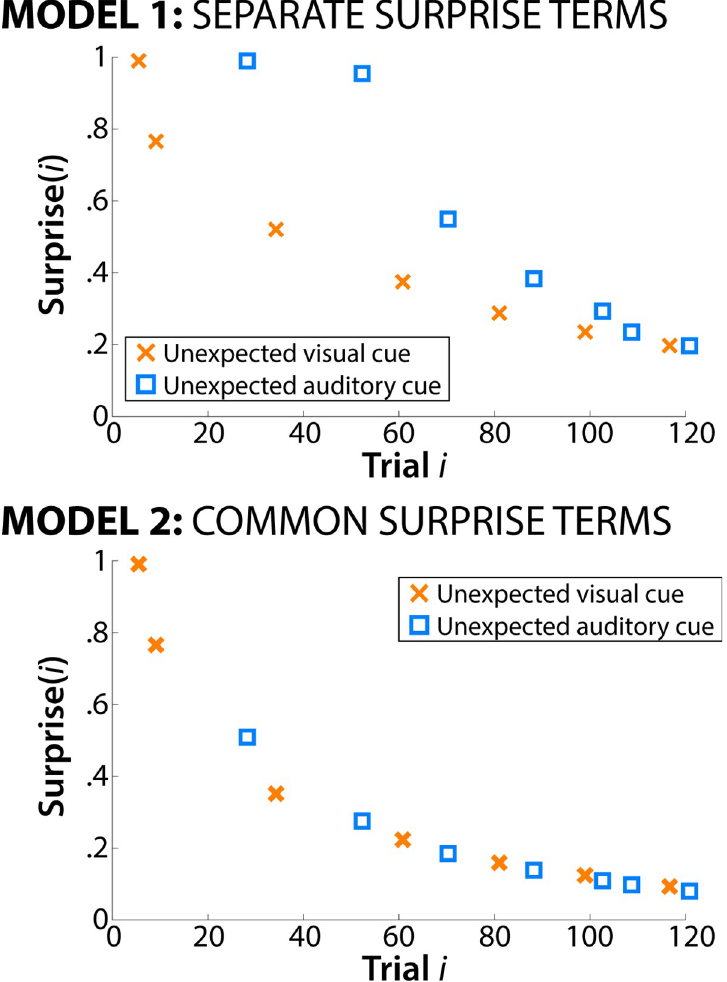
Fig 2. Single-subject example of surprise-term construction for each model. Top: Model 1 uses separate surprise terms for each sensory domain. In effect, the presence of a surprising event in one sensory domain does not inform the prior in the other sensory domain. Bottom: Model 2 uses a combined surprise term across both domains. In effect, all unexpected events, regardless of domain, influence the construction of the